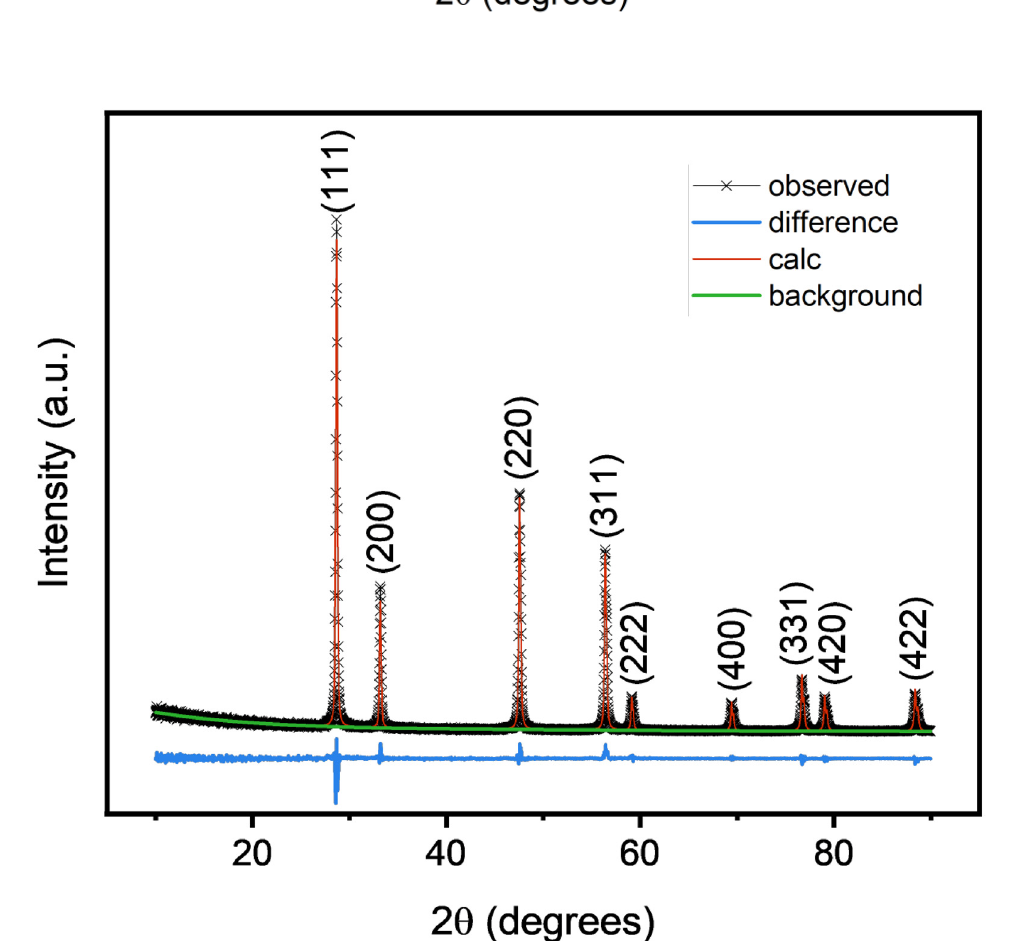
Figure 6. XRD patterns of the ( a ) oxalate precursor and ( b ) calcined Ce HEO. The calcined Ce HEO pattern (crosses) was refined using GSAS–II software to show single phase purity.